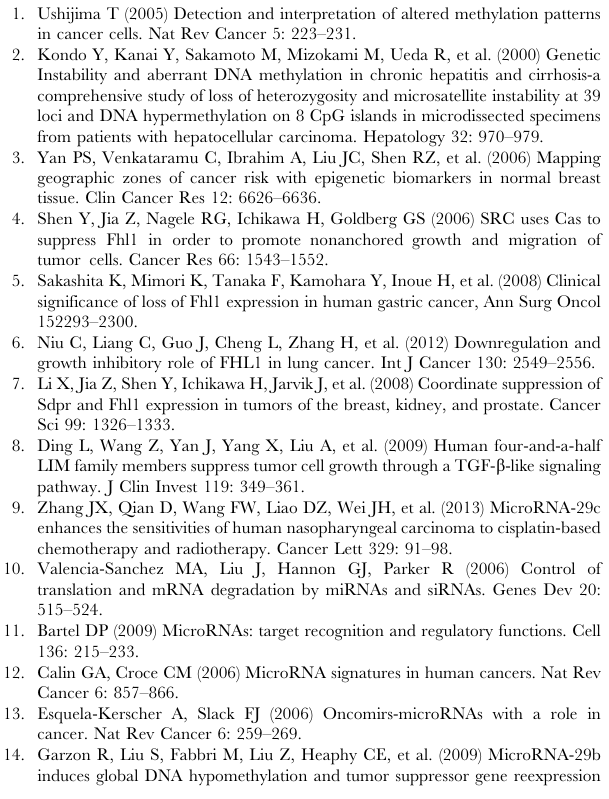
Table S1 Primers used for real-time RT-PCR. (DOC) Diagram S1 miR-410 promotes tumor growth in vitro and in vivo by downregulating FHL1 via methylation regulation in LS180 cells. (A) LS180 cells were transiently transfected with miR410 or control oligonucleotides and then were subjected to ChIP assay as detailed in the legend to Fig. S4. Results are shown for QPCR (top panel) and PCR product determination by agarose gel electrophoresis (bottom panel). (B) LS180 cells transiently transfected with miR-410 or control oligonucleotides. miR-410 was quantified by RT-QPCR and FHL1 expression was quantified by immunoblotting to verify the cell lines (left 2 panels). Cell growth assays were analyzed using validated cell lines (right panel). Data shown are mean 6 sd of triplicate measurements. * P , 0.05 versus control. (C) Cell viability was assessed using migration transwell assays 48 h post transfection. Scale bar, 100 m m. * P , 0.05 versus control. (D) Volume of xenograft tumors derived from LS180 cells expressing control oligonucleotides or miR-410. Data are shown as mean 6 sd ( n = 8). * P , 0.05, ** P , 0.01 versus control. (E) RT-qPCR analysis of DNMT3A, FHL1 and miR-410 in LS180 tumors harvested from in vivo animal experiments. * P , 0.05 versus